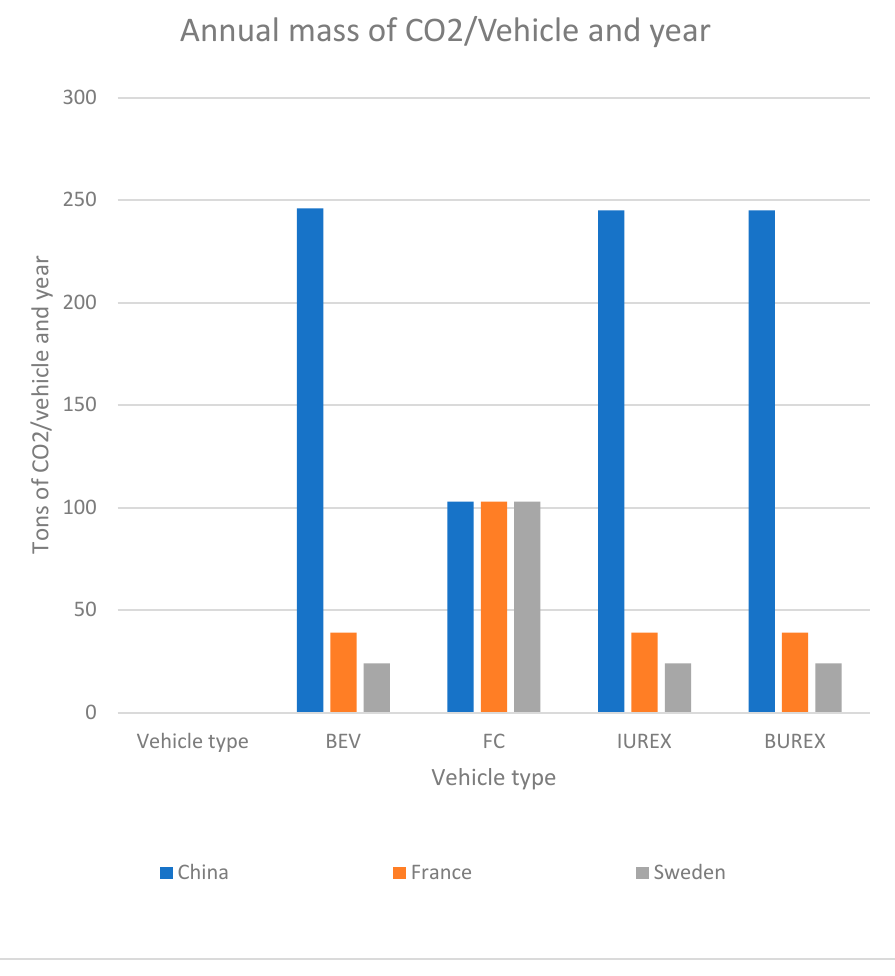
Figure 7. The local electricity generation mix strongly affects the potential of REX and FC systems to reduce CO 2 emissions.